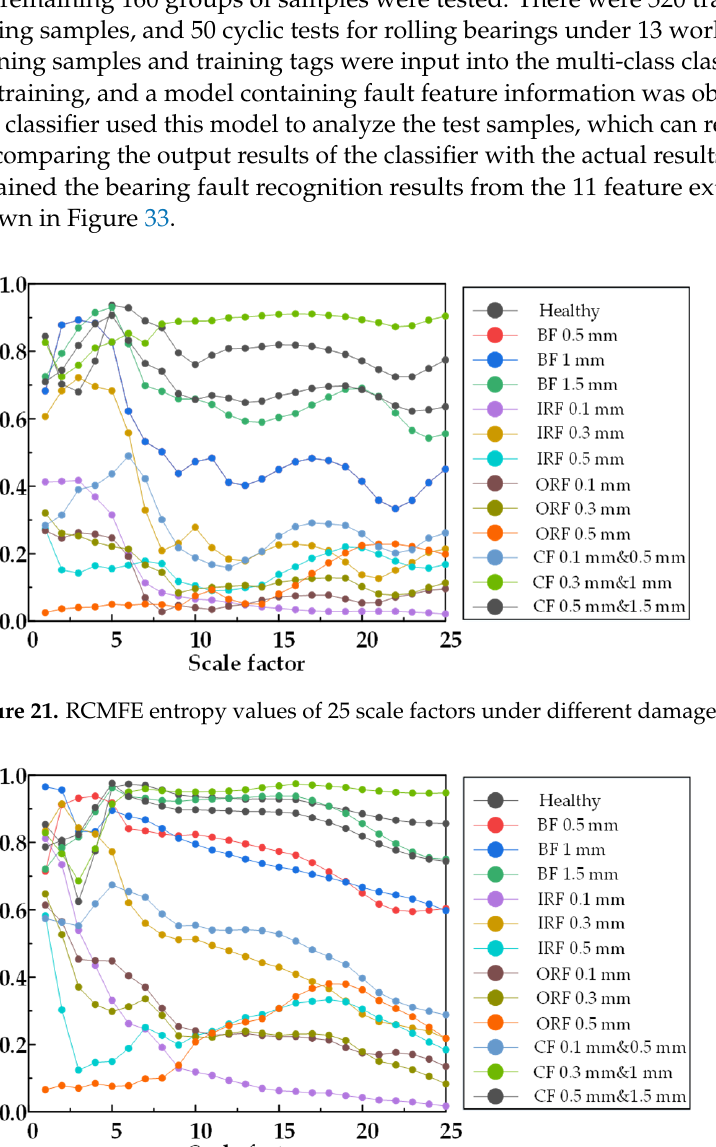
Figure 22. RCMDE entropy values of 25 scale factors under different damage degrees.